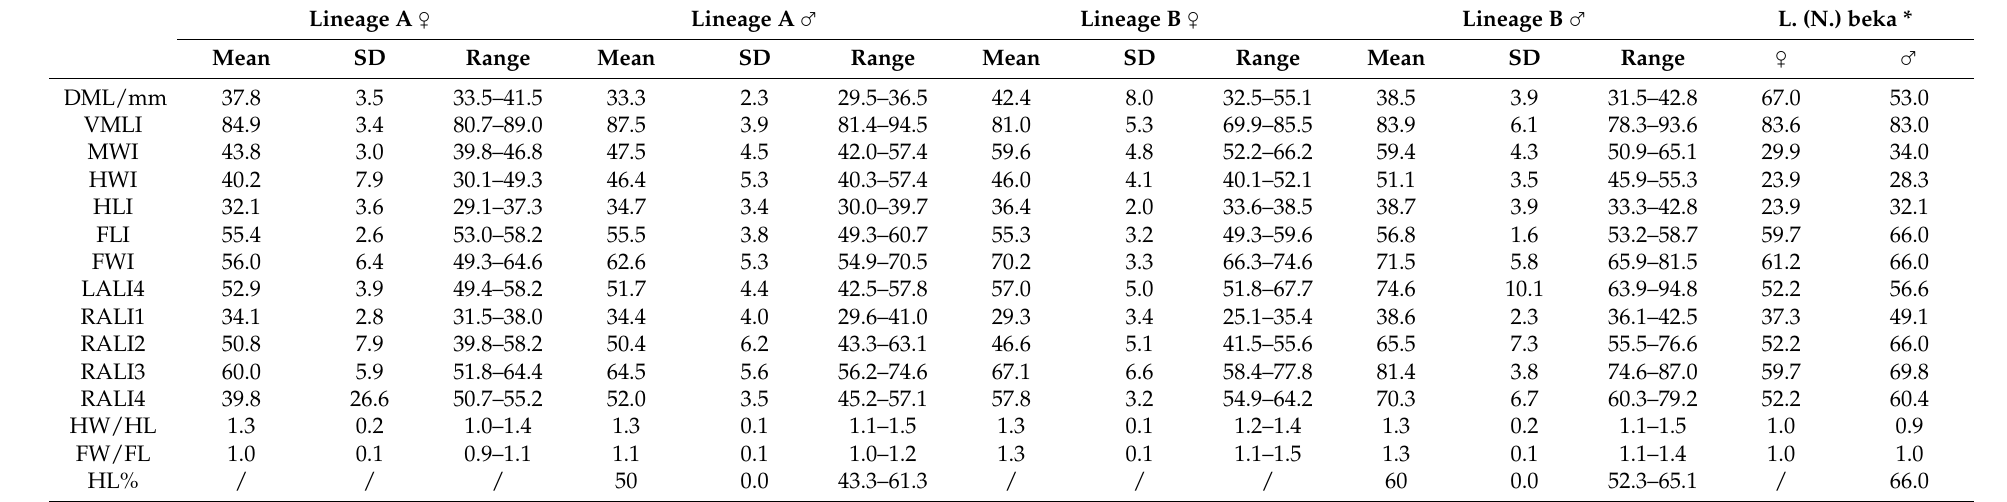
Table 5. Comparison of morphological measurements of L. ( N. ) beka Lineage A and Lineage B with type